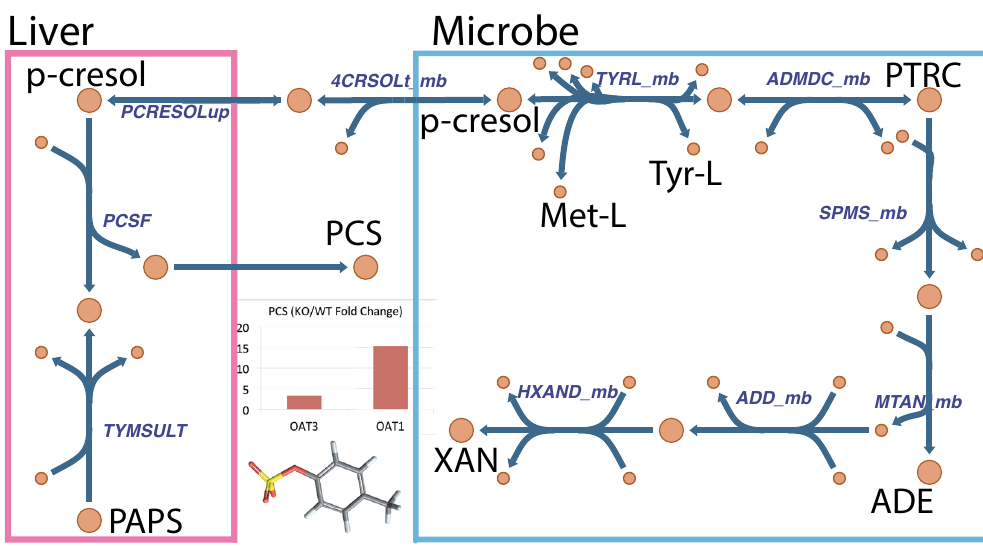
Figure 9. Analysis of liver-microbiome interactions connects host (liver) and gut microbial metabolic pathways via transport of p -cresol. There were significant changes in some metabolites detected in the serum that were specific to microbial biosynthesis pathways. This schematic illustration of parts of L-methionine and L-tyrosine pathways connecting host and microbiome metabolism via p -cresol, a metabolite that cannot be produced by mice or humans, was observed to be significantly altered in OAT1 as well as OAT3 knockouts. This map reveals the hepatic-microbial linkage for p -cresol metabolism. Tyrosine lyase acting upon L-tyrosine and S